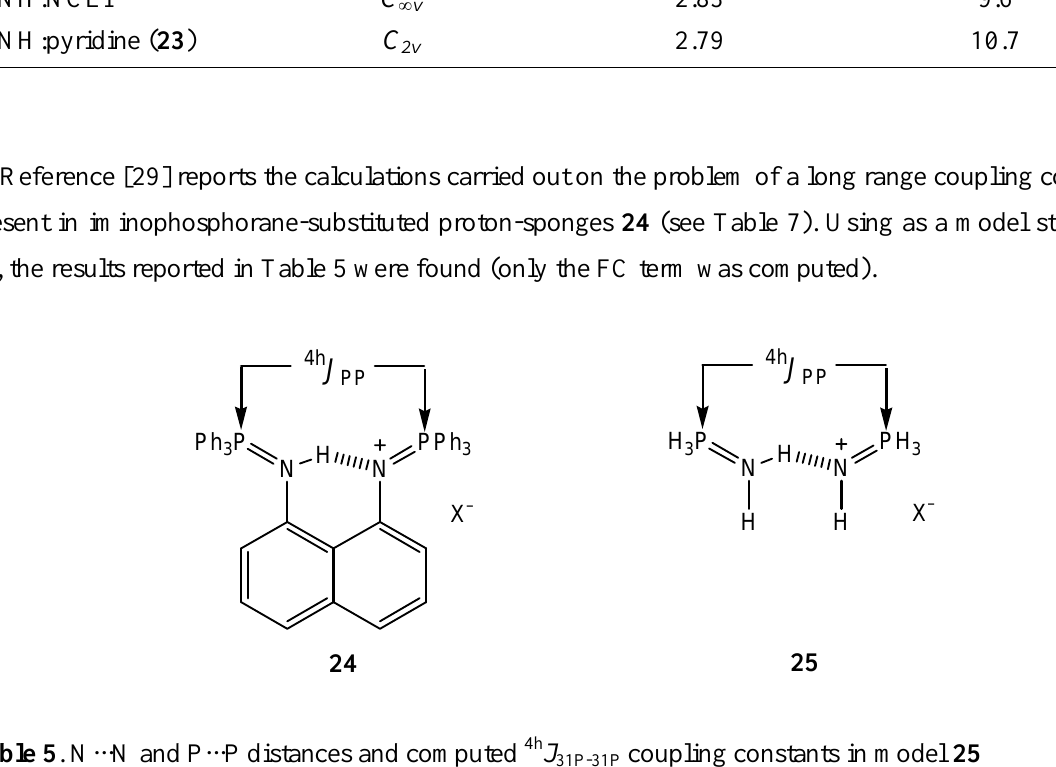
Table 5 . N···N and P···P distances and computed 4h J N···N distance